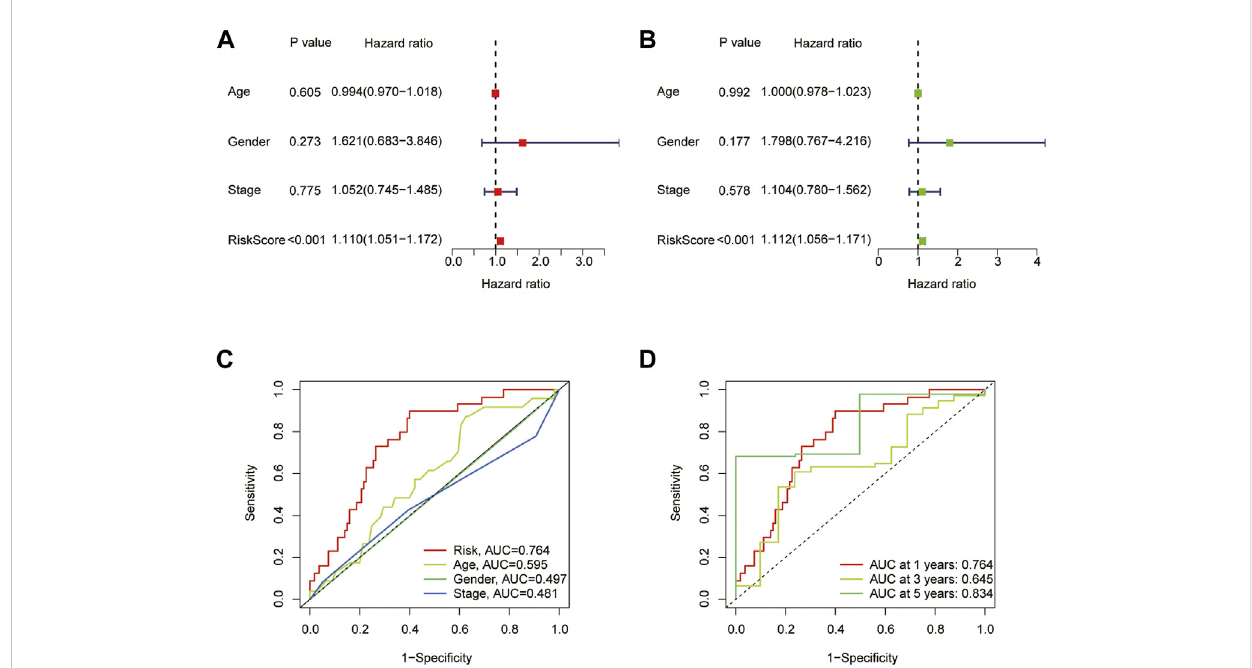
FIGURE 4 The prognostic valueof the signature for ESCA. (A) UnivariateCox analysis based on age, gender, stage, and risk scores. (B) Multivariate Cox analysis basedonage,gender,stage,andriskscores. (C) Comparison ofthepredictiveaccuracyofriskmodelsandclinicopathologicalcharacteristics. (D) ROCof the risk characteristic based on a whole-group prediction of 1, 3, and 5-year